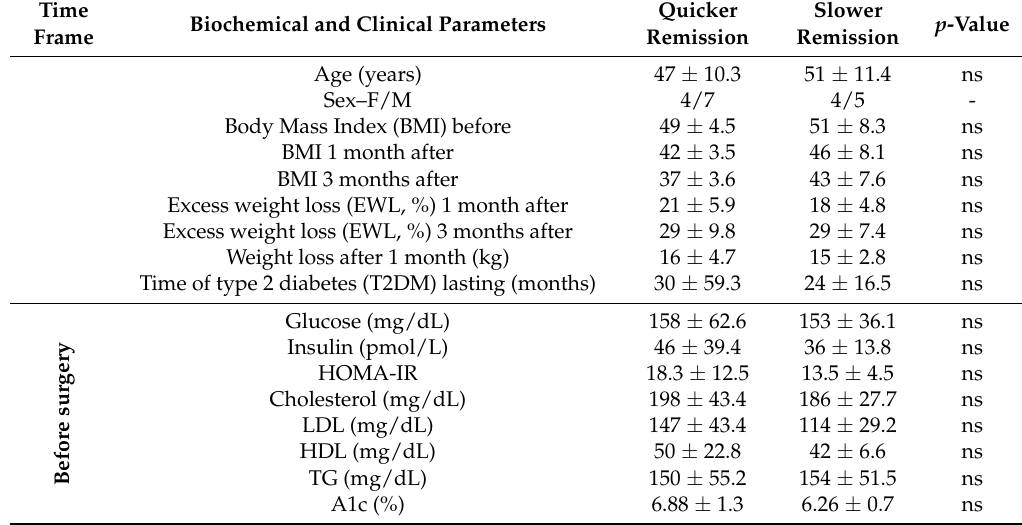
Table 1. Characteristics of study participants.